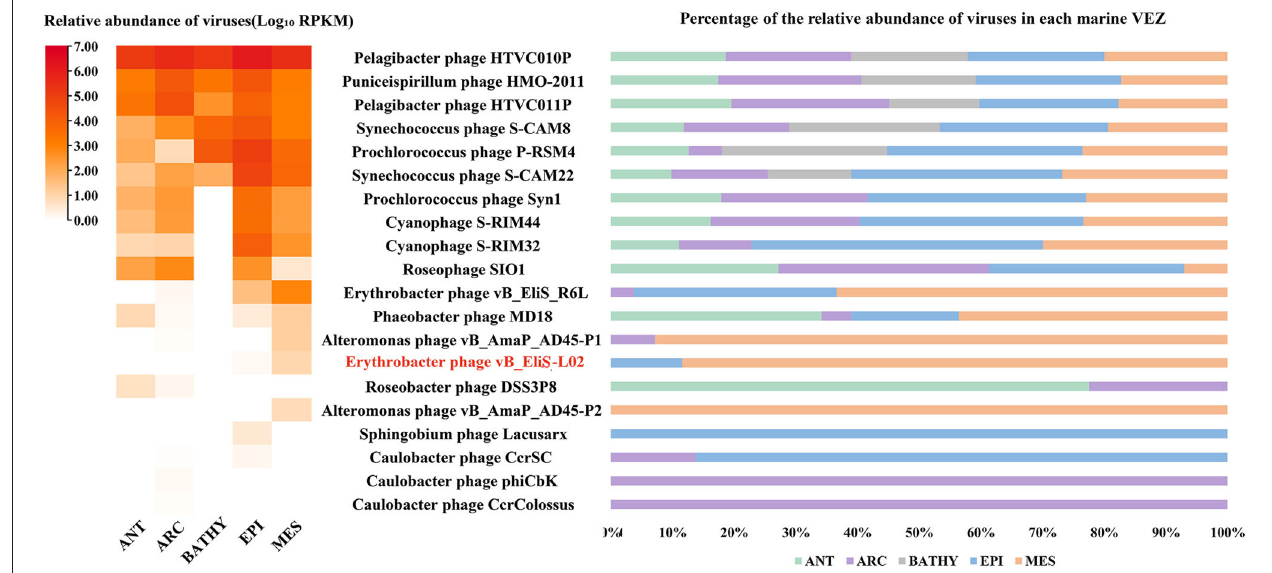
FIGURE 6 | Relative abundance of Erythrobacter phage vB_EliS-L02 compared to the abundances of oceanic representative bacteriophages and Cbk-like phages. Relative abundances are expressed by RPKM (reads per kilobase per million mapped reads) values and described with log 10 transformation. Left, relative abundances of different bacteriophages in different viral ecological zones (VEZs). Right, distribution patterns of bacteriophages in five VEZs with RPKM values normalized by the number of databases of each VEZ. ANT, Antarctic; ARC, Arctic; BATHY, bathypelagic; EPI, temperate and tropical epipelagic; MES, temperate and tropical